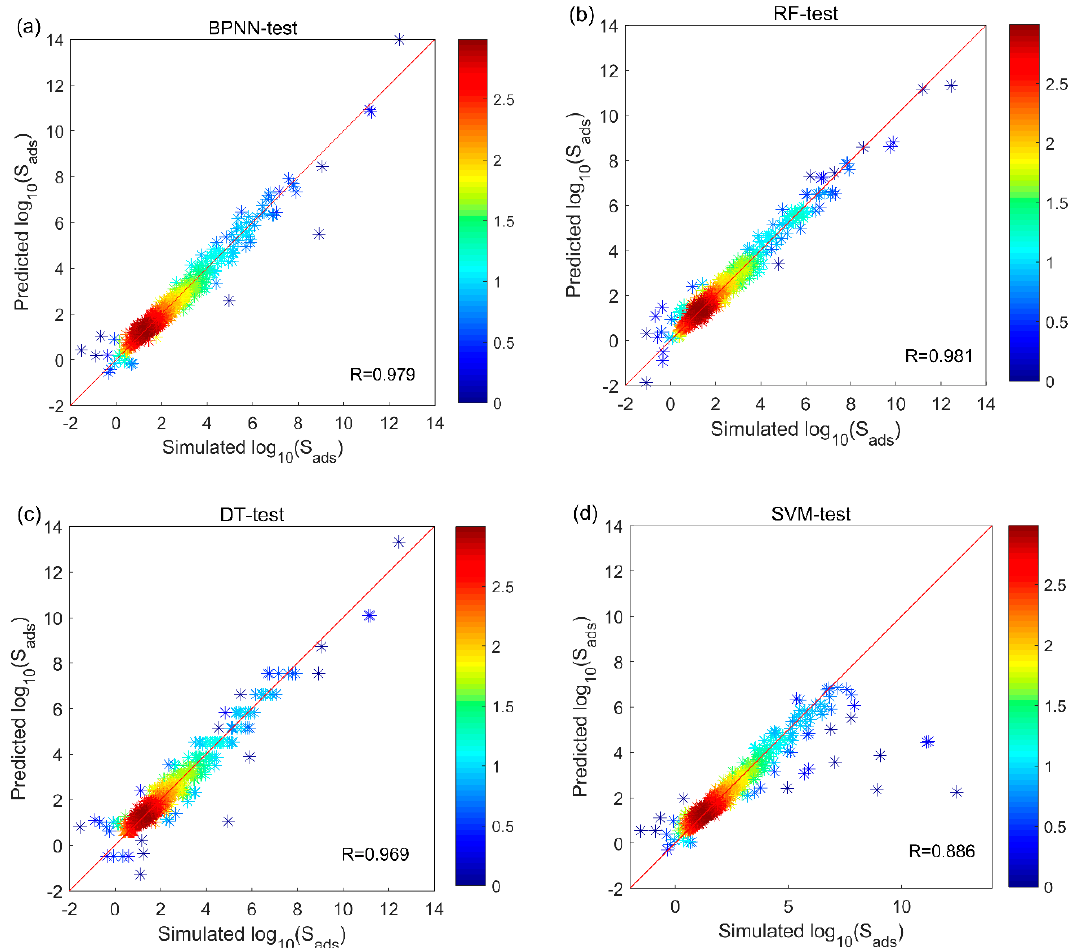
Figure 4. The test results of four machine-learning (ML) algorithms predicted versus simulated S ads(CO2 / N2 + O2) using ρ , φ , VSA, LCD, PLD and heat of adsorption. ( a ) back propagation neural network (BPNN), ( b ) random forest (RF), ( c ) decision tree (DT), ( d ) support vector machine (SVM). The color of point represents the number of metal-organic frameworks (MOFs), and the unit of number is a base-10 logarithm of MOF numbers. Appl. Sci. 2020 , 10 , x FOR PEER REVIEW 9 of 13 Table 1. The 4 ML algorithms for predicting the correlation coefficient R value of the adsorption selectivity.